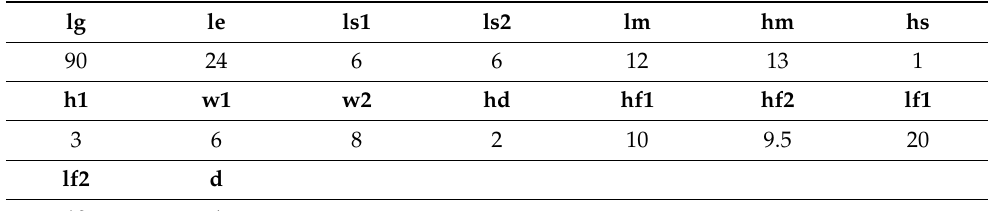
Table 1. The specific dimensions of the antenna (units: